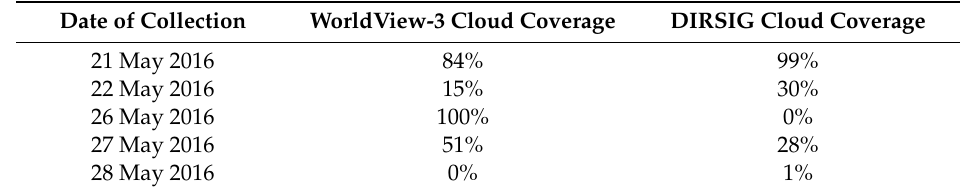
Table 2. Cloud coverage percentage for WorldView-3 vs. Digital Imaging and Remote Sensing Image Generation (DIRSIG) image collection